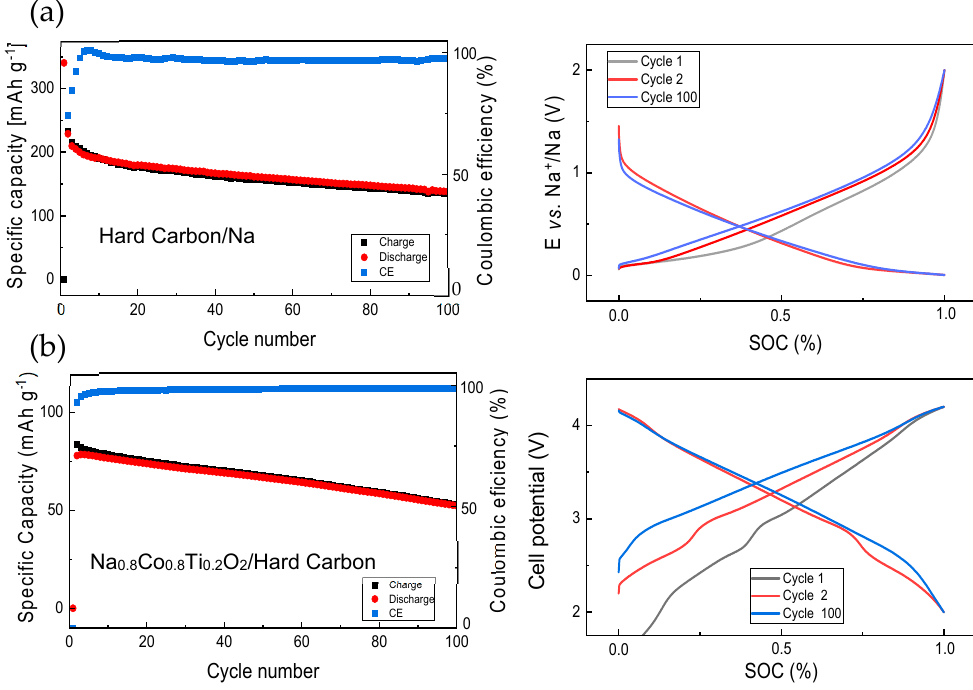
Figure 4. Electrochemical performance of ( a ) half cells with a hard carbon electrode and a metallic Na anode, at the current density of 34.4 mA g − 1 (0.1 C) and ( b ) full cells containing Na 0.8 Co 0.8 Ti 0.2 O 2 cathode (13.6 mg) and hard carbon anode (8.7 mg), cycled at the current density of 0.1C calculated for the cathode amount, together with development of charge—discharge curves during selected cycles.